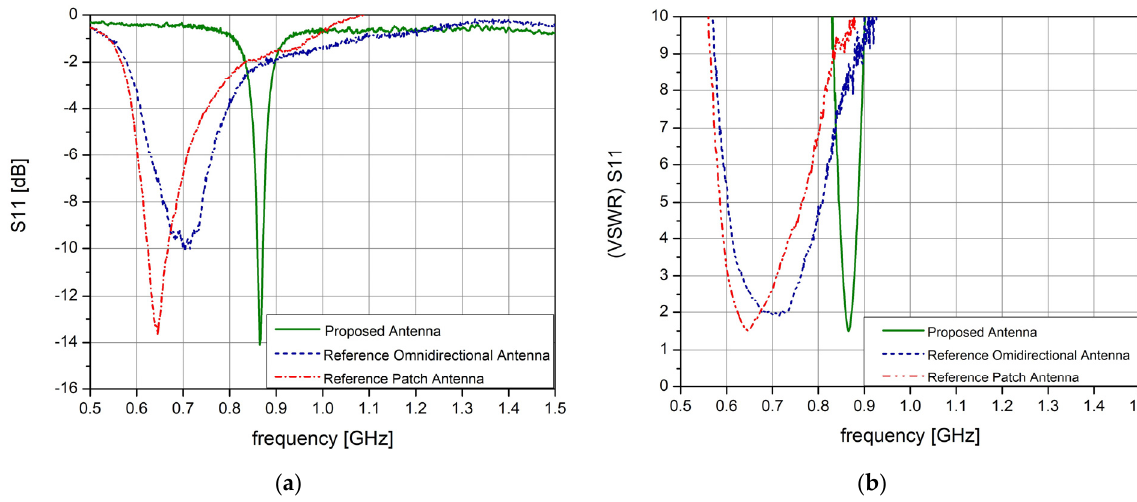
Figure 14. Test results: ( a ) reflection coefficient; ( b ) VSWR.